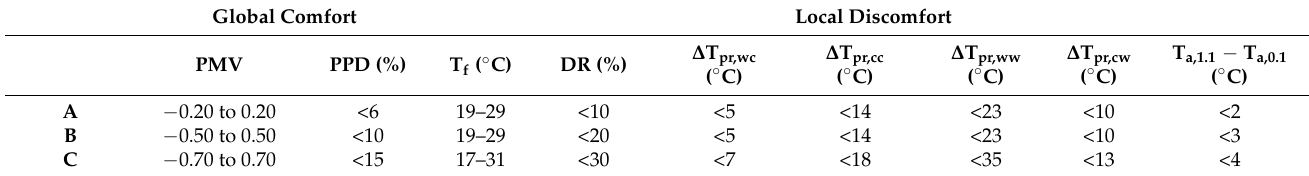
Table 1. Categories of thermal comfort and local discomfort according to ISO 7730. Global Comfort Local